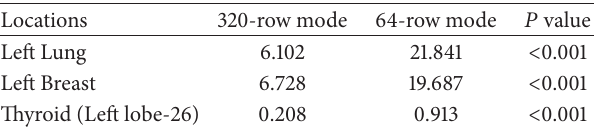
Table 1: Comparison of Absorbed Radiation Dose (ARD) (mGy) for radiosensitive organs (Lung, Breast and Thyroid) between prospective imaging at 320-row MDCT versus prospective/step & shoot method at 64-rowMDCT adjusting the effects of tube voltages and heart